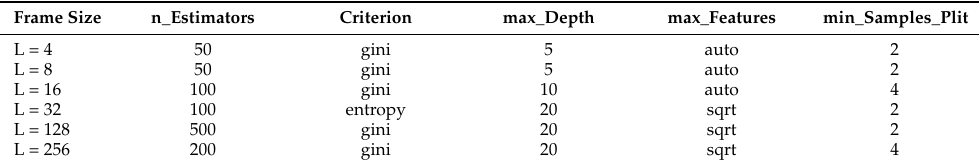
Table 4. Grid search results of RF Hyper-parameters for a particular frame